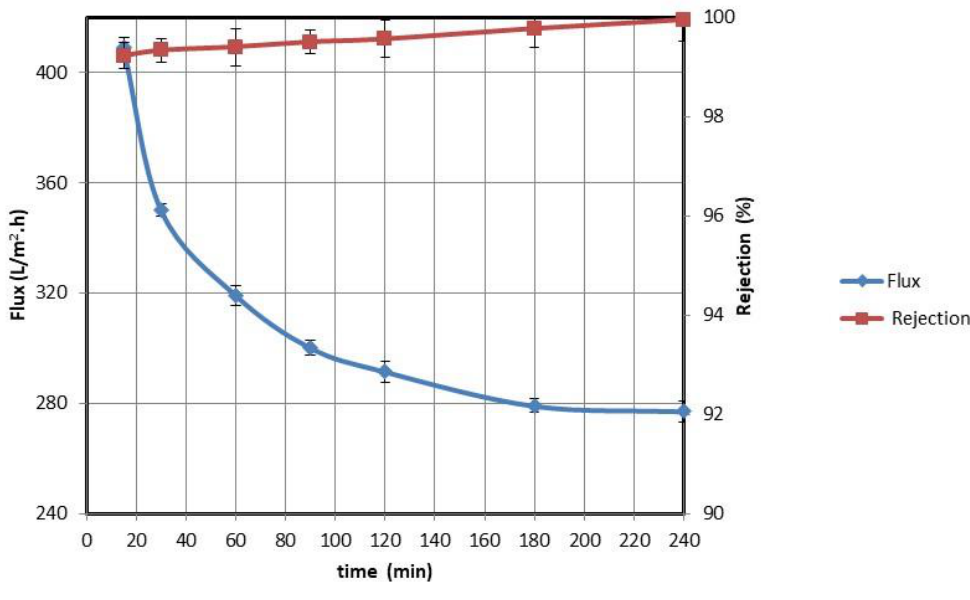
Figure 10. Flux rate of a real oil-contaminated water sample through the fabricated membrane and percentage rejection at different times.